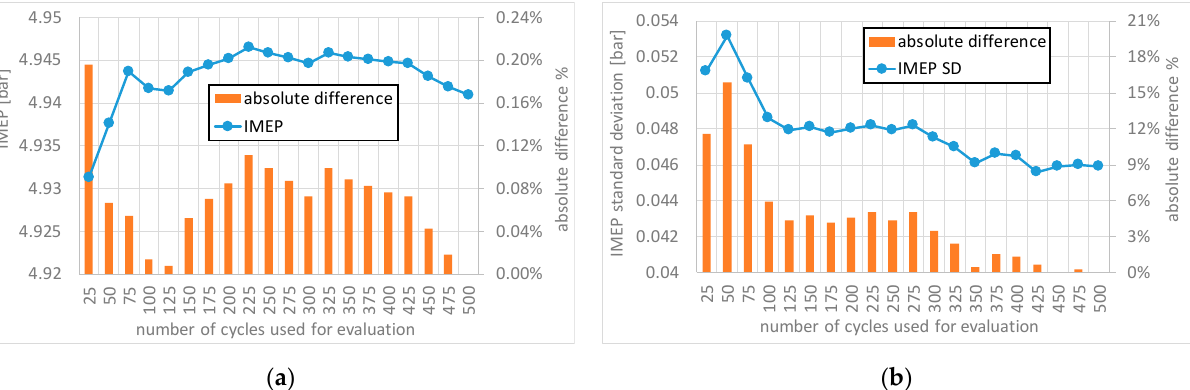
Figure 9. MAP = 0.5 bar, engine speed n = 3000 rpm. ( a ) average IMEP and absolute difference% vs. number of cycles taken for evaluation; ( b ) IMEP SD and absolute difference% vs. number of cycles taken for evaluation.